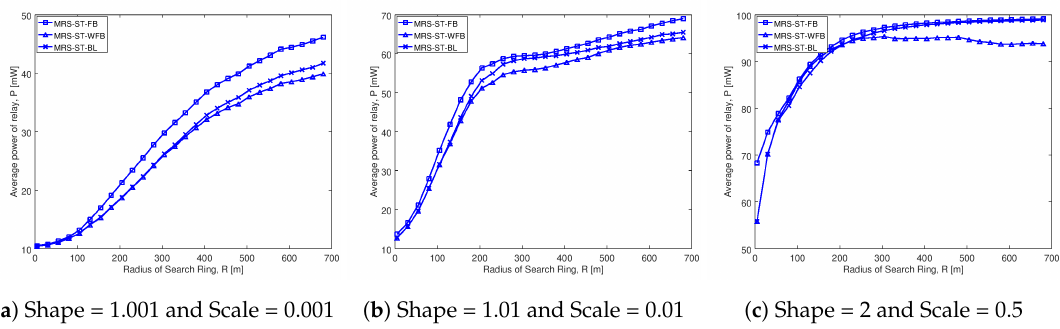
Figure A6. Average transmission power comparison of various schemes in different social trust scenarios when network width is 1000